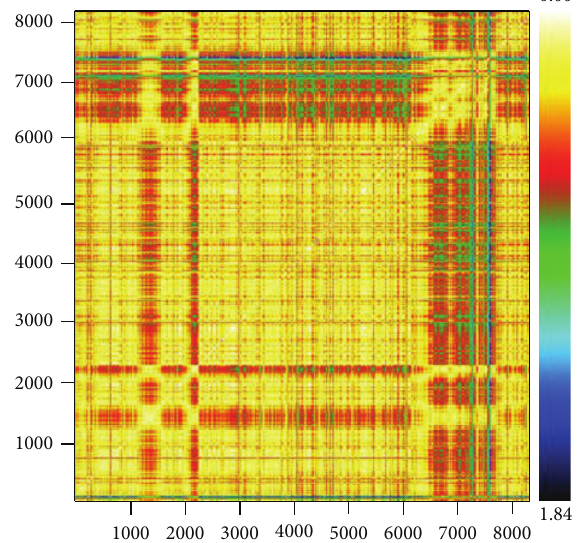
Figure 10: The recurrence plot of the DTG.